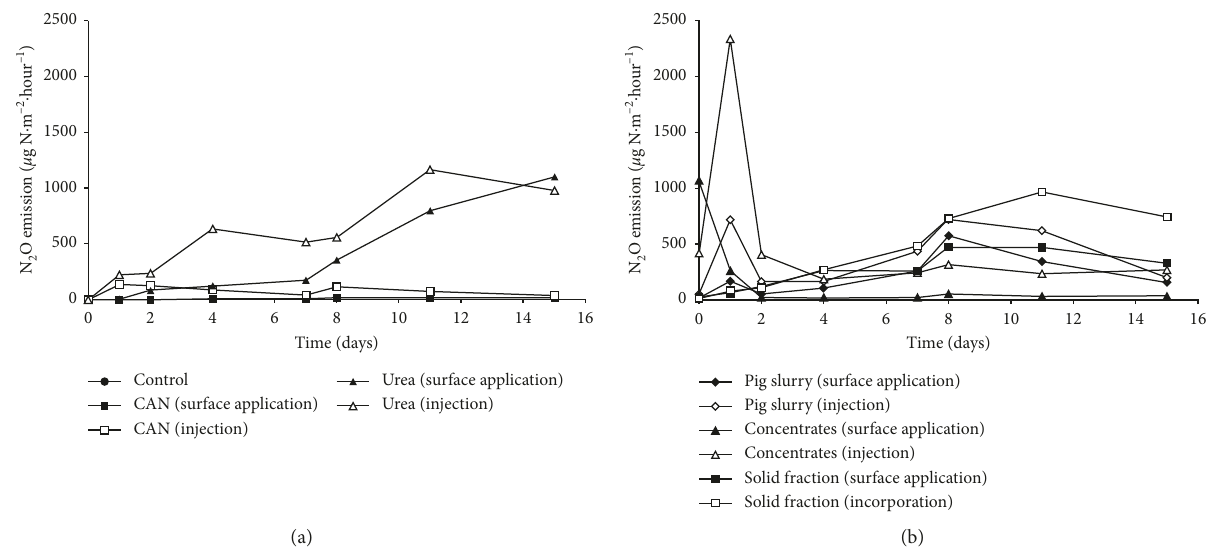
Figure 2: Nitrous oxide emission from incorporated and surface-applied fertilizers (a) and manures (average of four plants in (b)) applied to an arable sandy soil. Results of an incubation experiment with samples from an arable sand soil. After 7 days, 7mm water was added to simulate rainfall. See Table 2 for the total emissions of all treatments of this